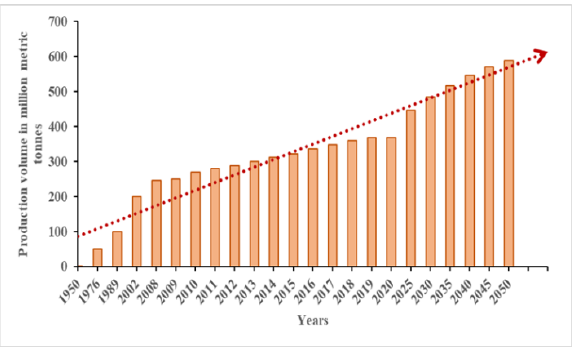
Figure 1. Worldwide production of plastic [48,49].